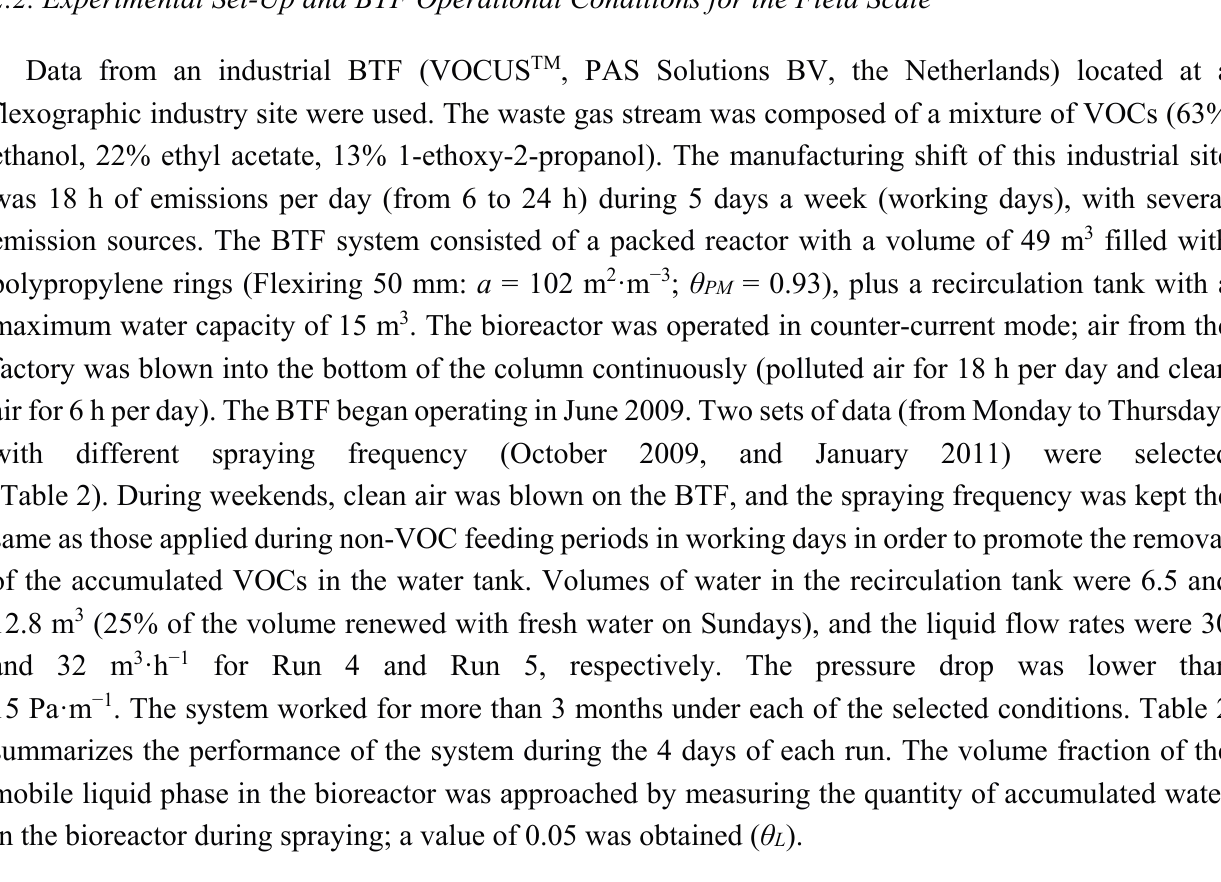
Table 2. Overall performance of the industrial biotrickling filter